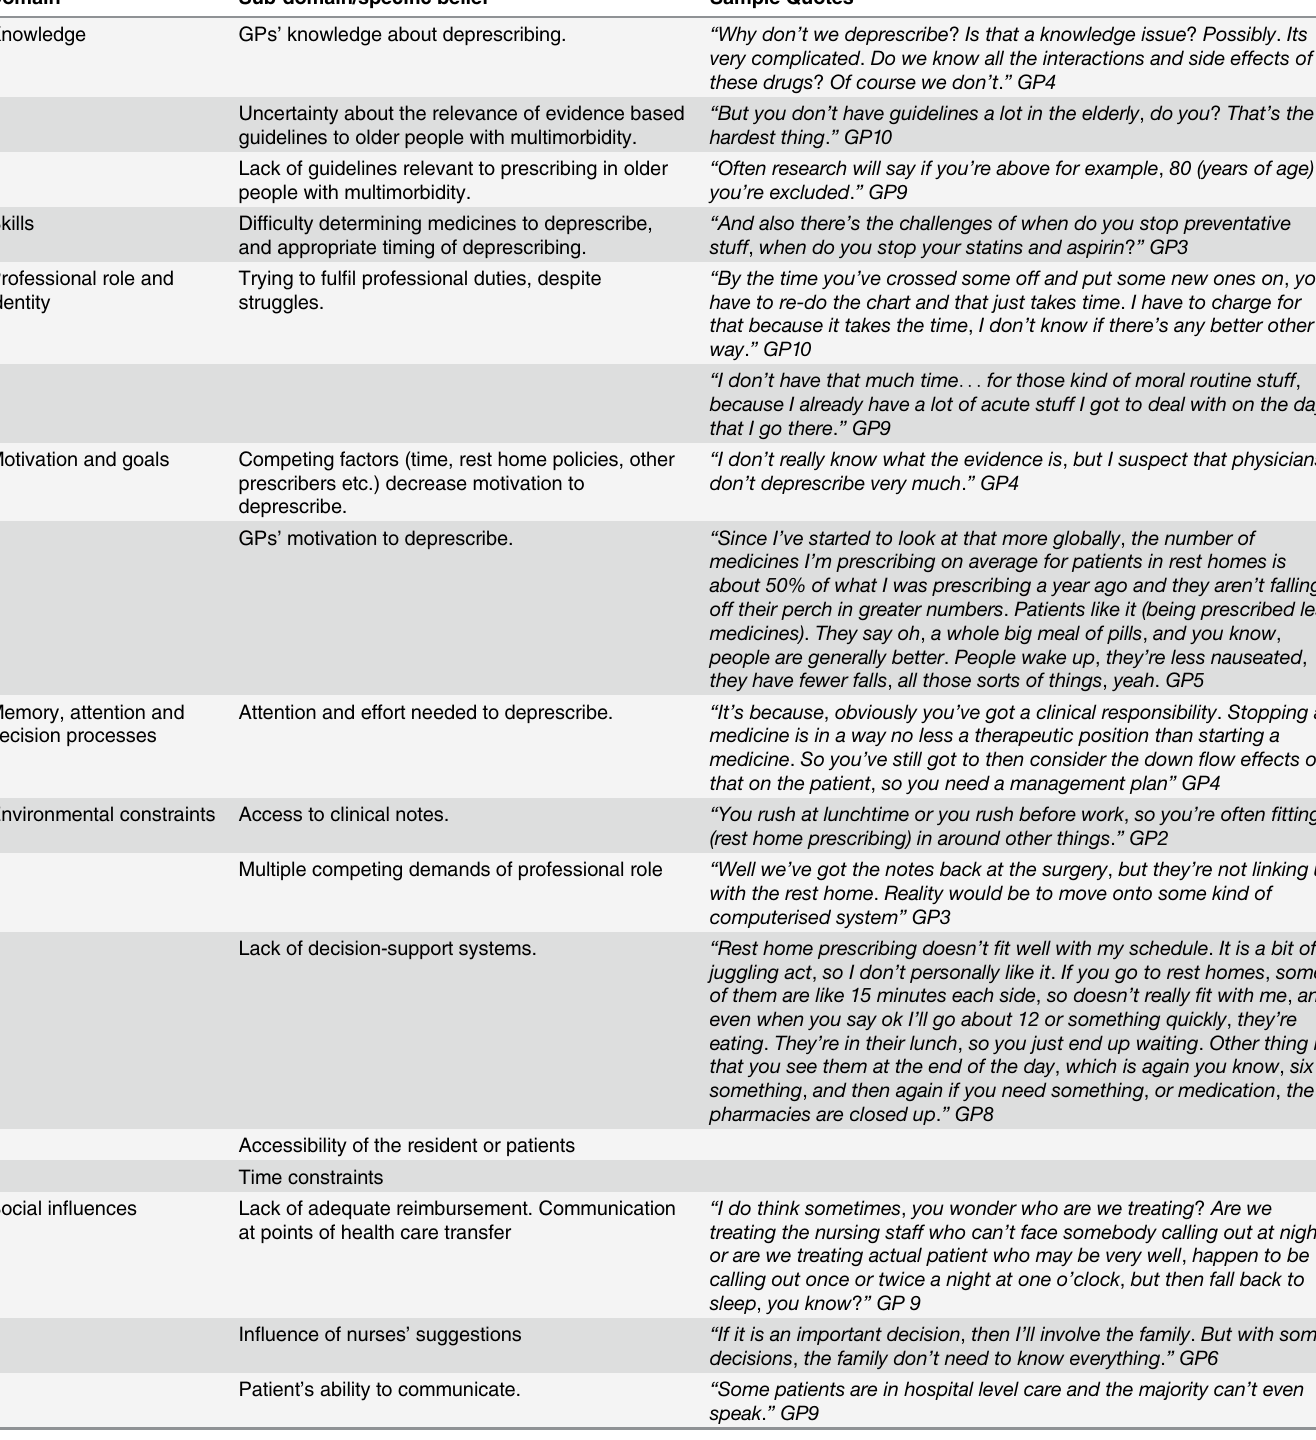
Table 3. Behaviour change factors related to